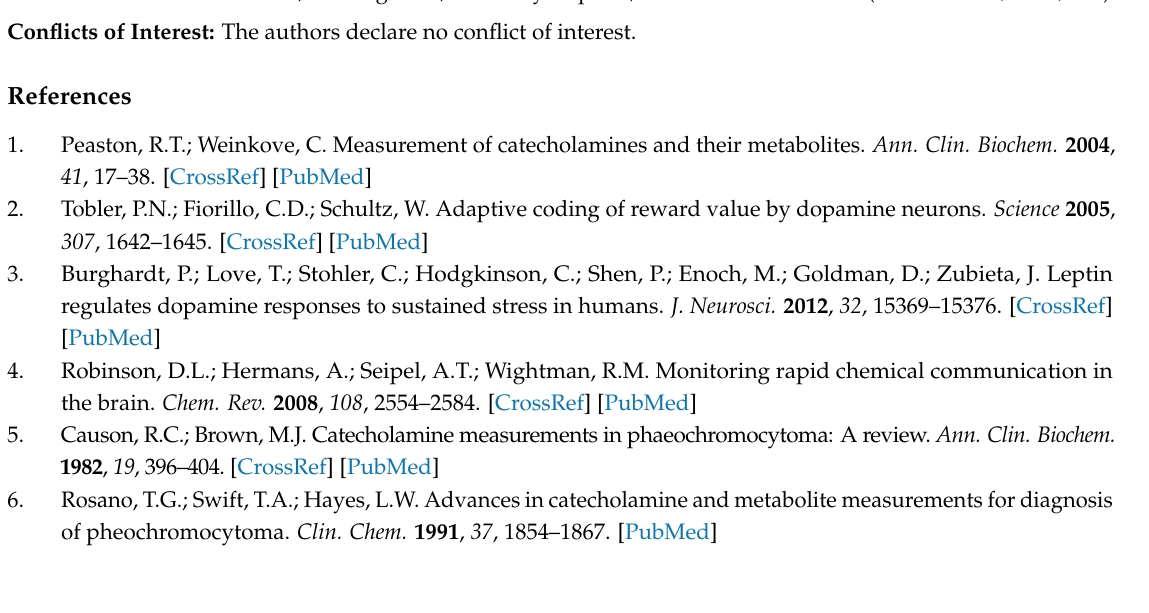
Supplementary Materials: The apparent concentration of different neurotransmitter in the silica gel electrode as function of the incubation time (Figure S1) are available online at